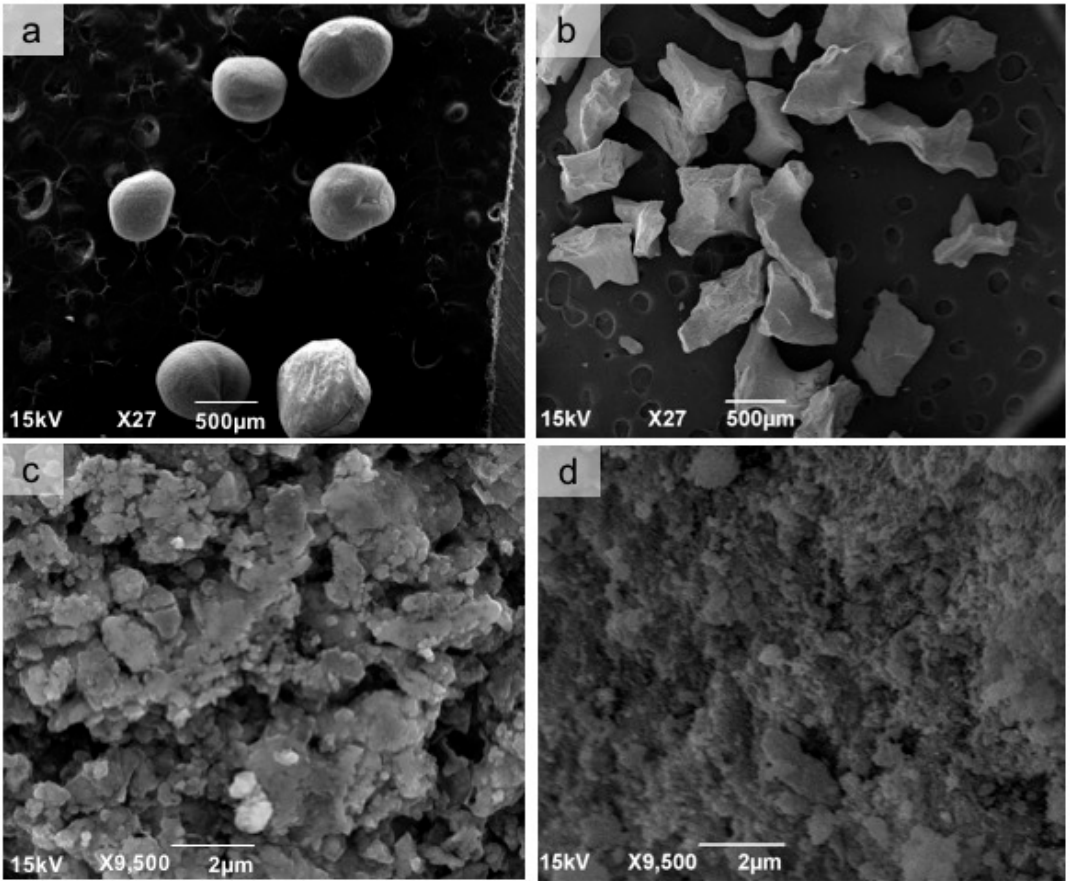
Figure 1. Scanning electron microscopy (SEM) micrographs of the biomaterial groups at 27 × magnification, scale bar = 500 µ m ( a , b ) to observe the morphology of spheres and granules and 9,500 × magnification, scale bar = 2 µ m ( c , d ) to observe the surface parameters: CHA ( a , c ) and Bio-Oss ® ( b , d ).